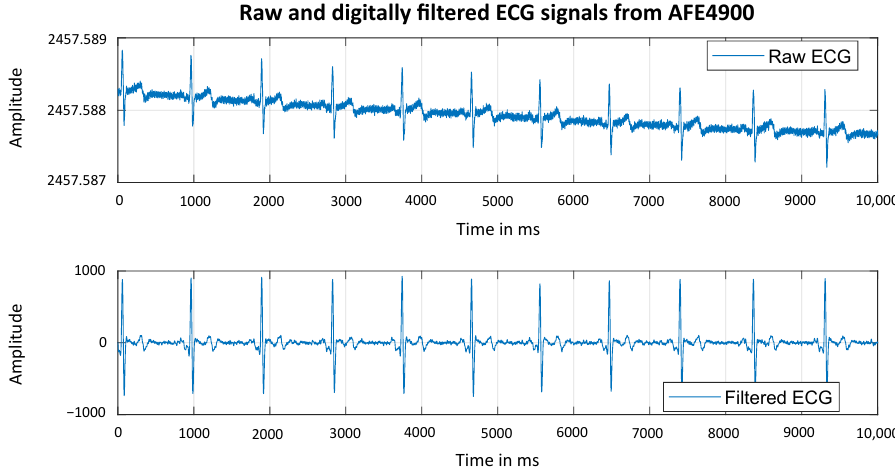
Figure 8. Comparisonbetween standardized PQRST-complexes simulated by the phantom 320 ECG simulator and recorded simultaneously with both SPECTRE 3.0’s AFE4900 and a 12bit-oscilloscope. Additional tests are performed to test the ECG signal quality. The upper graph in Figure 9 shows the raw (unfiltered) ECG signal obtained with SPECTRE 3.0. from one of the authors. The signal shows a drift resulting from minor motion artifacts. Additional digital filtering using the evaluation software further enhances the signal by reducing noise, normalizing the signal, and eliminating trends and motion artifacts , as seen in Figure 9 in the graph below. The result is a signal with clearly visible R-peaks that allows subsequent PTT calculation.